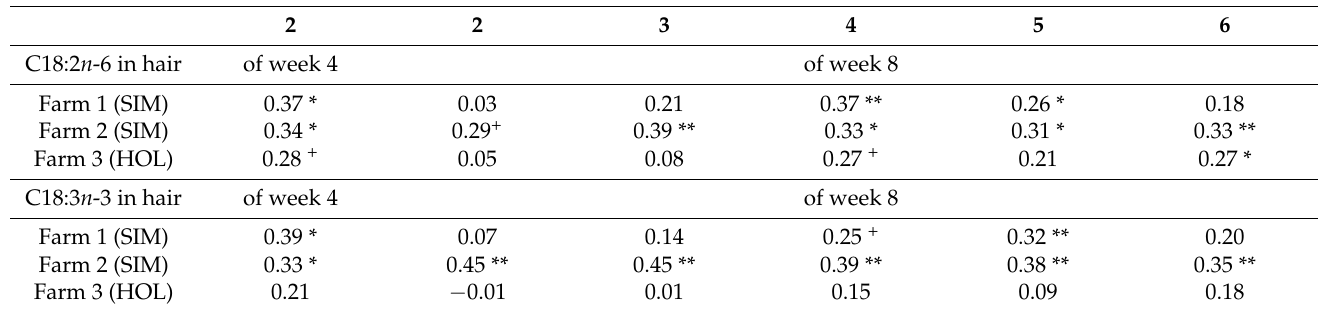
Table 5. Pearson’s correlation coefficients between energy intake per metabolic body weight (MJ NE L /BW 0.75 /d) in lactation weeks 2 to 6 corrected for feeding group and lactation number in farm 1 (SIM), farm 2 (SIM), and farm 3 (HOL), and C18:2 n -6 and C18:3 n -3 contents in the hair of weeks 4 and